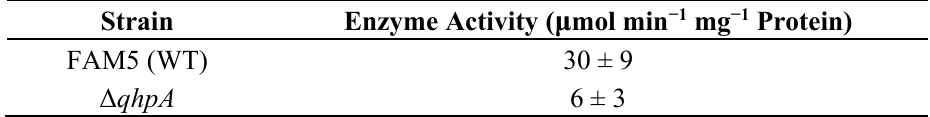
Table 4. Activity of the heme-containing amine dehydrogenase in wild type and Δ qhpA- mutant strains upon growth on